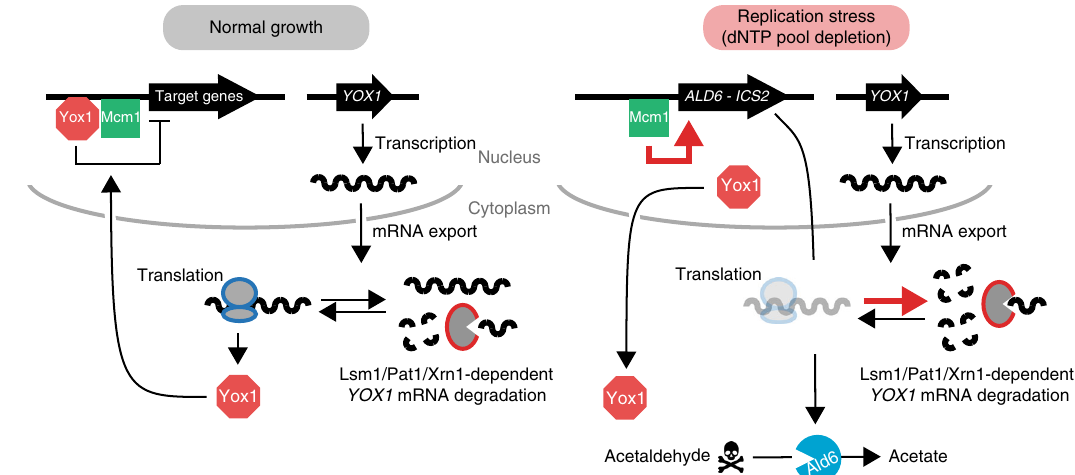
Fig. 8 A model for YOX1 post-transcriptional regulation by P-bodies during replication stress. During normal growth YOX1 mRNA is produced and exported to the cytoplasm where it can either be degraded or translated. YOX1 mRNA translation produces a transcriptional repressor that is imported to the nucleus where it binds the Mcm1 antirepressor to represses the transcription of target genes. During replication stress induced by hydroxyurea treatment, P-body formation is increased which results in increased YOX1 mRNA degradation ( red arrow ). Export of the Yox1 protein from the nucleus concomitant with degradation of the YOX1 mRNA allows the cells to control the amount of the Yox1 repressor in the nucleus. Decreased nuclear Yox1 relieves transcriptional repression ( red arrow ) of target genes required for HU resistance, including ALD6 and ICS2 . De-repression of ALD6 promotes degradation of acetaldehyde, a molecule that is strongly toxic during replication